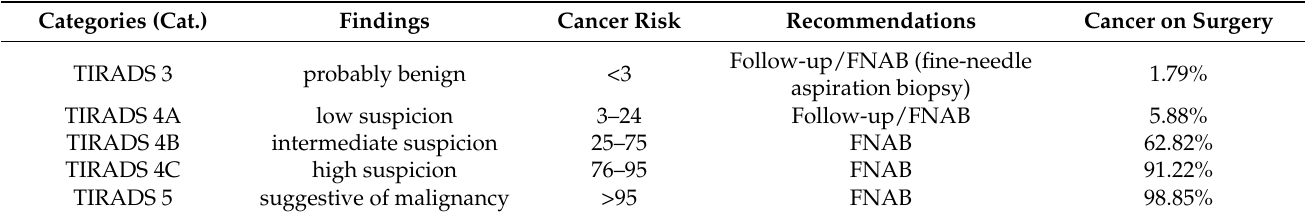
Table 1. TIRADS categories in this study.